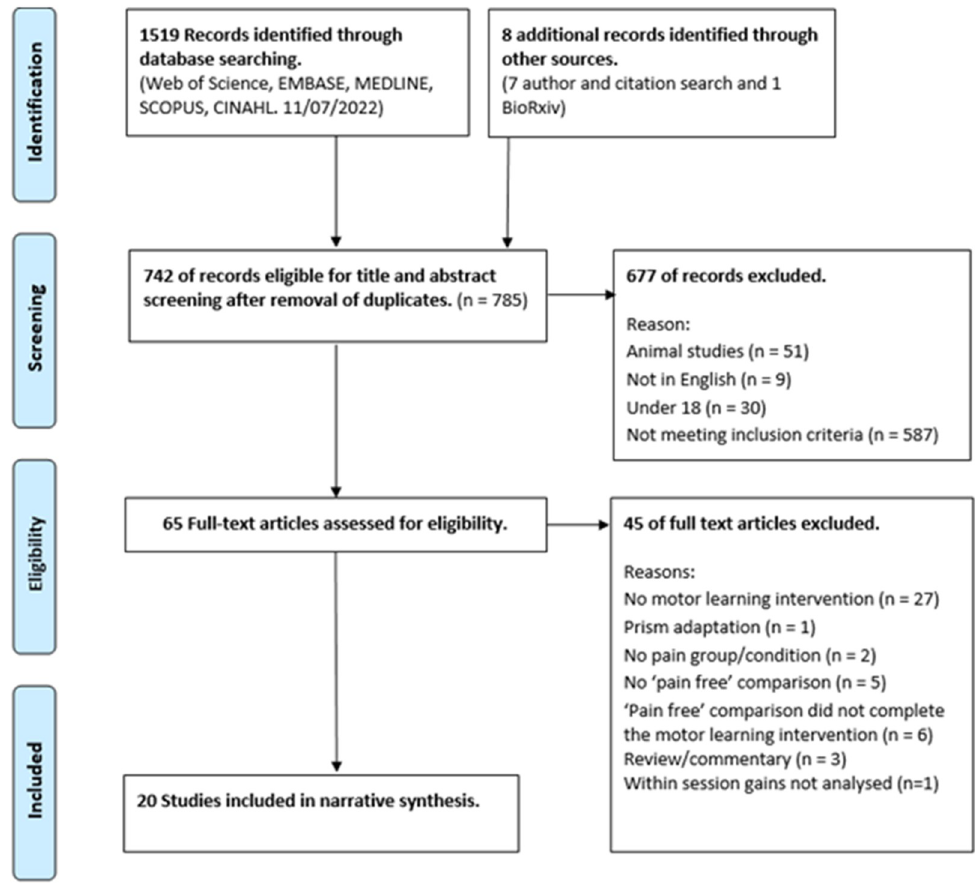
Fig 1. PRISMA flow